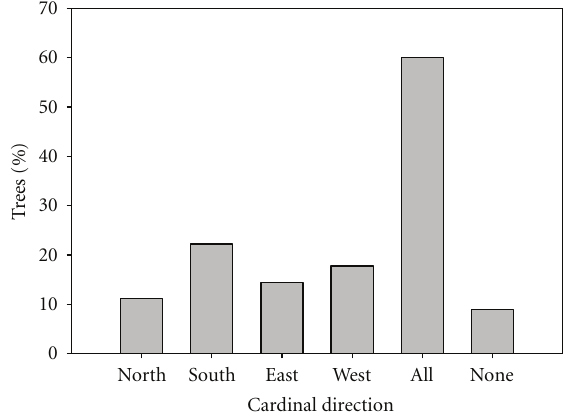
Figure 5: Percentage of trees with termite tubes oriented in each direction. All indicate that termite tubes were present in all four